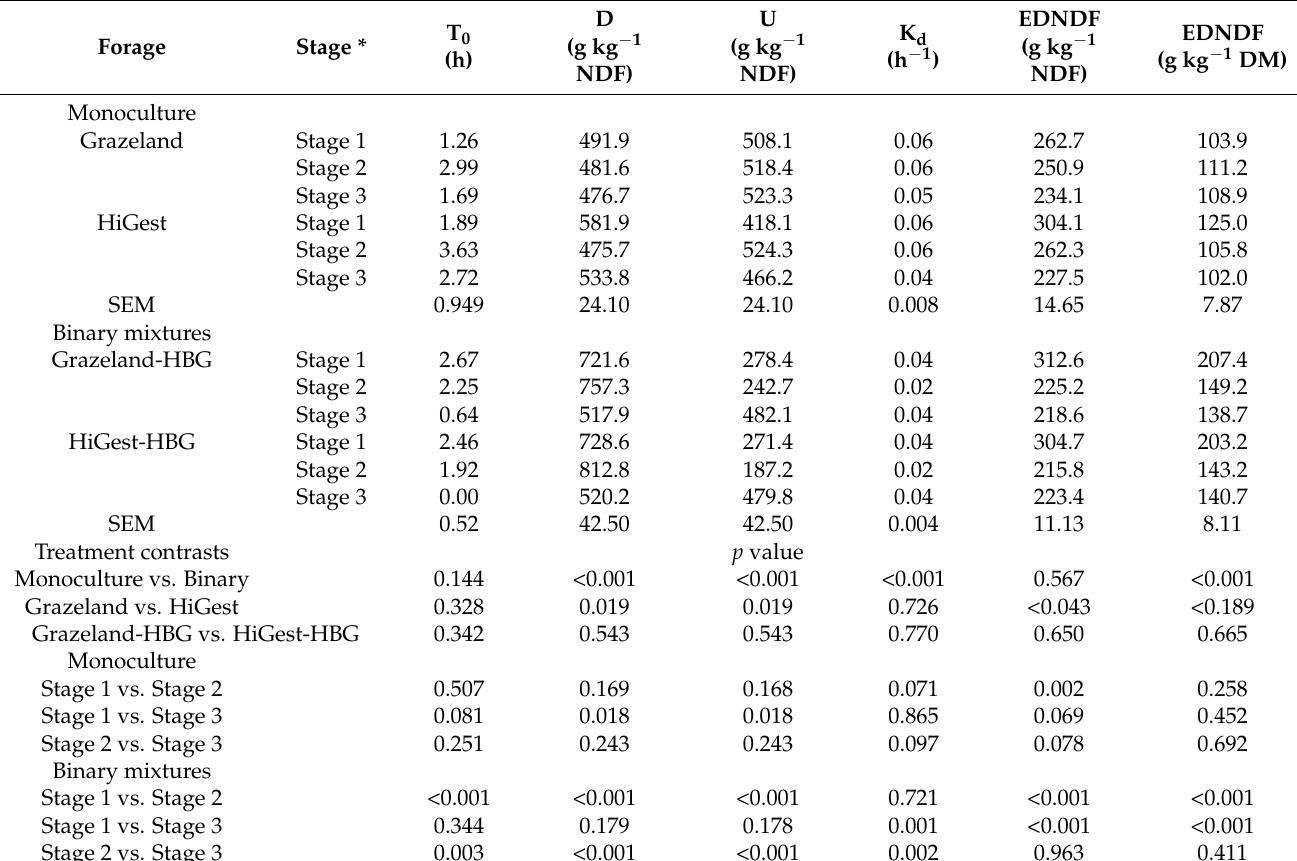
Table 7. Effects of cultivar, maturity, and their interaction on in situ rumen degradation kinetics of neutral detergent fiber (NDF) of alfalfa cultivars in monoculture and in binary mixtures with AC Success hybrid bromegrass (HBG) in Lanigan, Saskatchewan